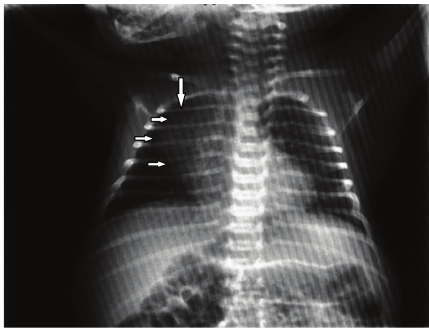
Figure 2: Enlargement of the cardiac silhouette in the right atrial region in posterior anterior chest radiography (marked with arrows).